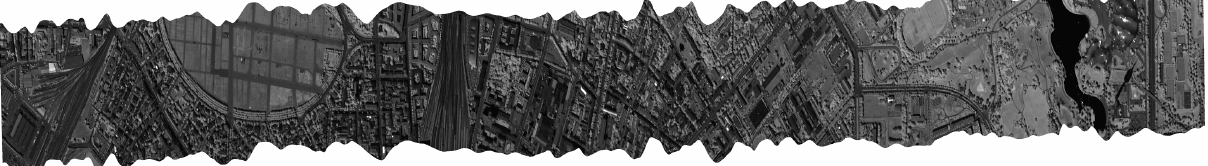
Figure 1: Orthorectified SWIR channel